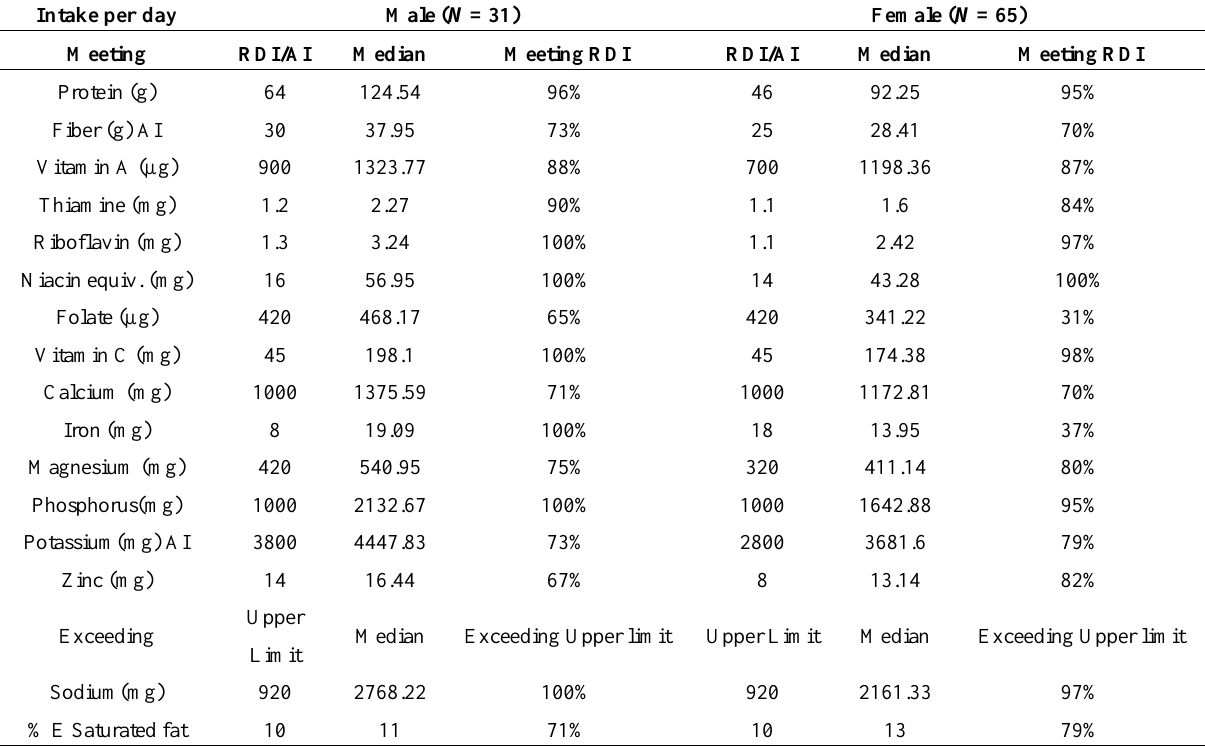
Table 2. Comparison of adult nutrient intakes, as assessed by the Australian Eating Survey (AES) food frequency questionnaire (FFQ), to Australian Recommended Dietary Intakes (RDI), Adequate Intake (AI) and upper limit, by